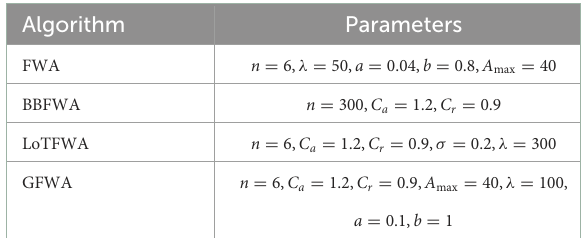
TABLE 5 Parameters for fireworks